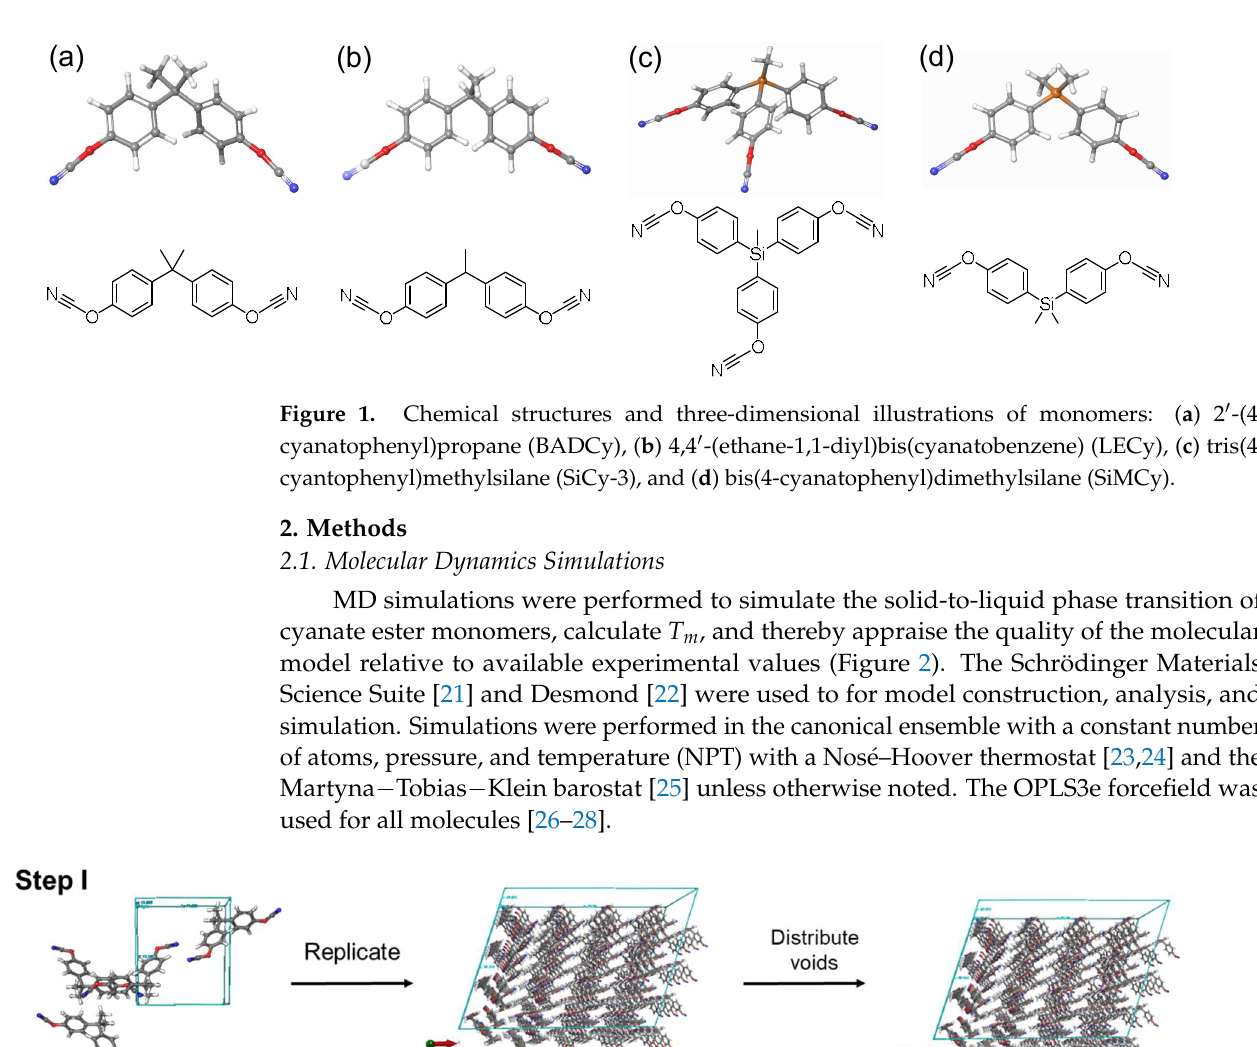
Figure 2. Molecular Dynamics (MD) workflow of melting temperature simulations.